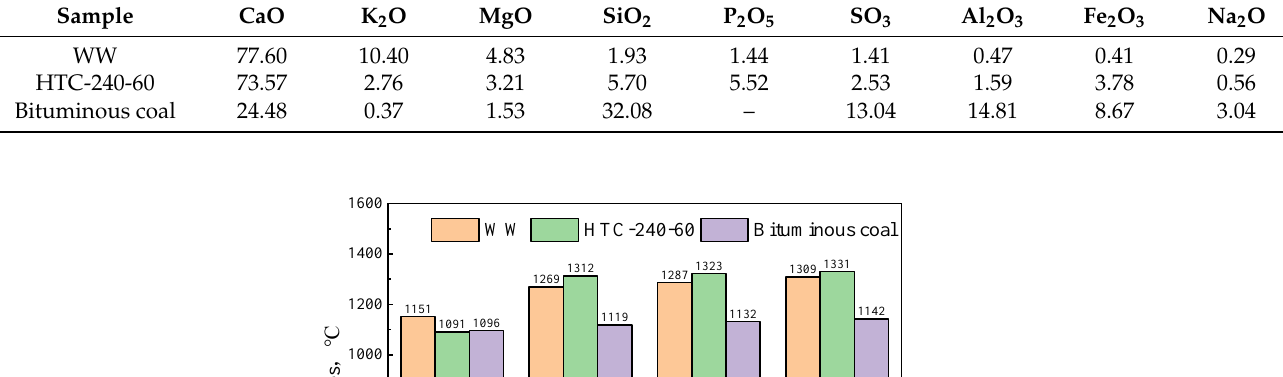
Table 5. Ash composition of WW and hydrochar, wt.%.